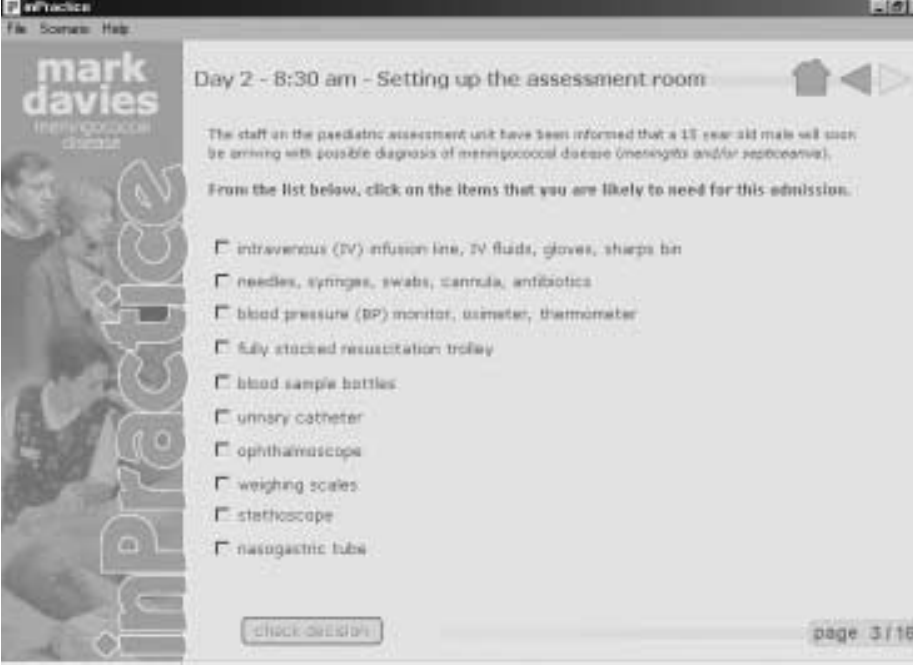
Figure 2. A typical question screen in an inPractice